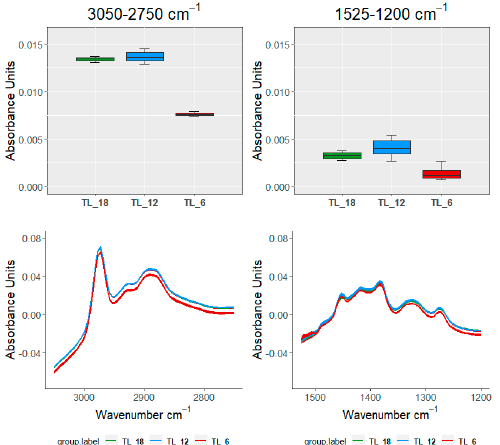
Figure 9. Plots of two of the four significant areas of the Traditional Oak (TL) curves. In the first row, vectorial analysis by means of boxplots. In the second row, FDA through curves in the studied interval. The wine spirit sample is divided into three groups depending on the ageing time (18, 12, and 6 months of ageing). Table 5. Results of the similarity contrast between the three ageing times (18 months, 12 months, and 6 months), depending on the ageing technology. Functional results (FDA) are based on functional ANOVA (FANOVA) using two different tests (FP: permutation test based on a representation of the base function, FB: F test with a reduced bias estimation method). In addition, the results of the ANOVA and Kruskal’s test representing the vectorial results (VA) are shown. All the results are p - values based on a 5% significance level.